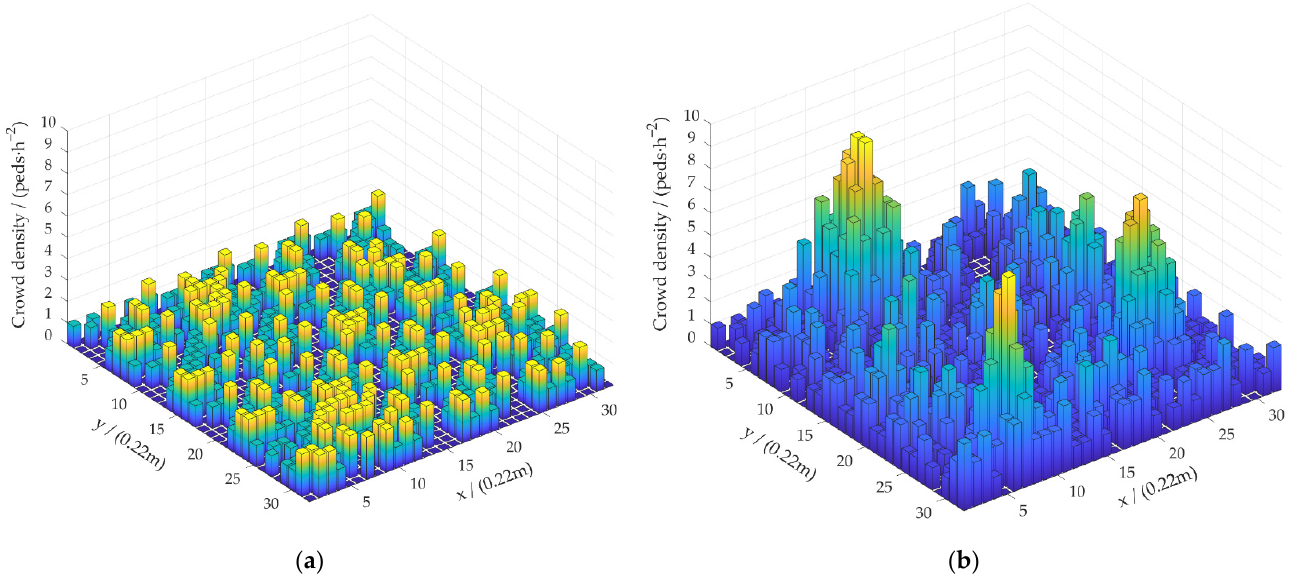
Figure 14. Detection results of crowd target when the clustering threshold is set to 0.5. ( a ) The crowd aggregation state. ( b ) The detection results of crowd target.